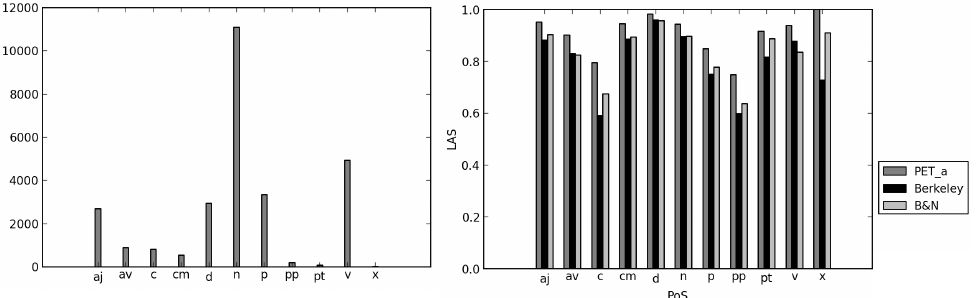
Figure 3: WSJ per-category frequency (left) and dependency accuracies (right) on coarse lexical head categories: adjective, adverb, conjunction, complementizer, determiner, noun, preposition, lexical prepositional phrase, punctuation, verb, and